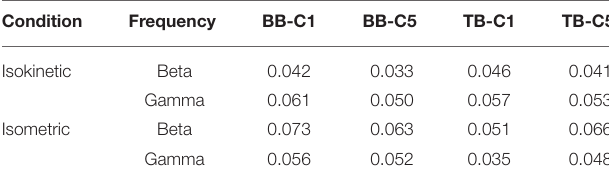
TABLE 1 | CMC sig value of a representative participant according